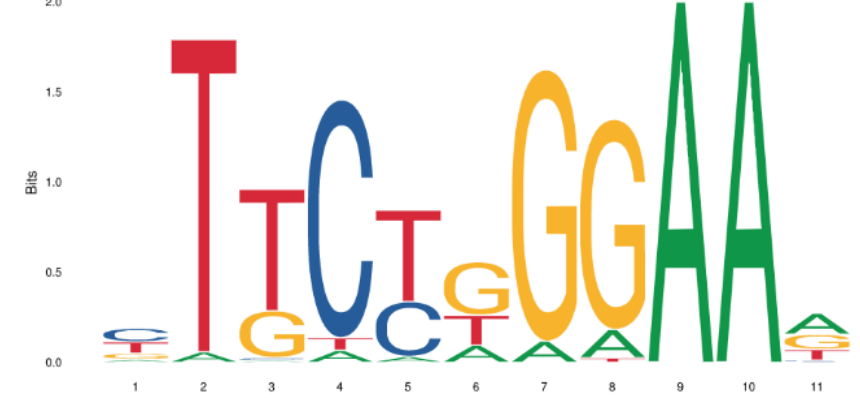
Figure 1. The STAT3 Jaspar matrix logo. The logo of the matrix STAT3 from the Jaspar database on which experiments have been